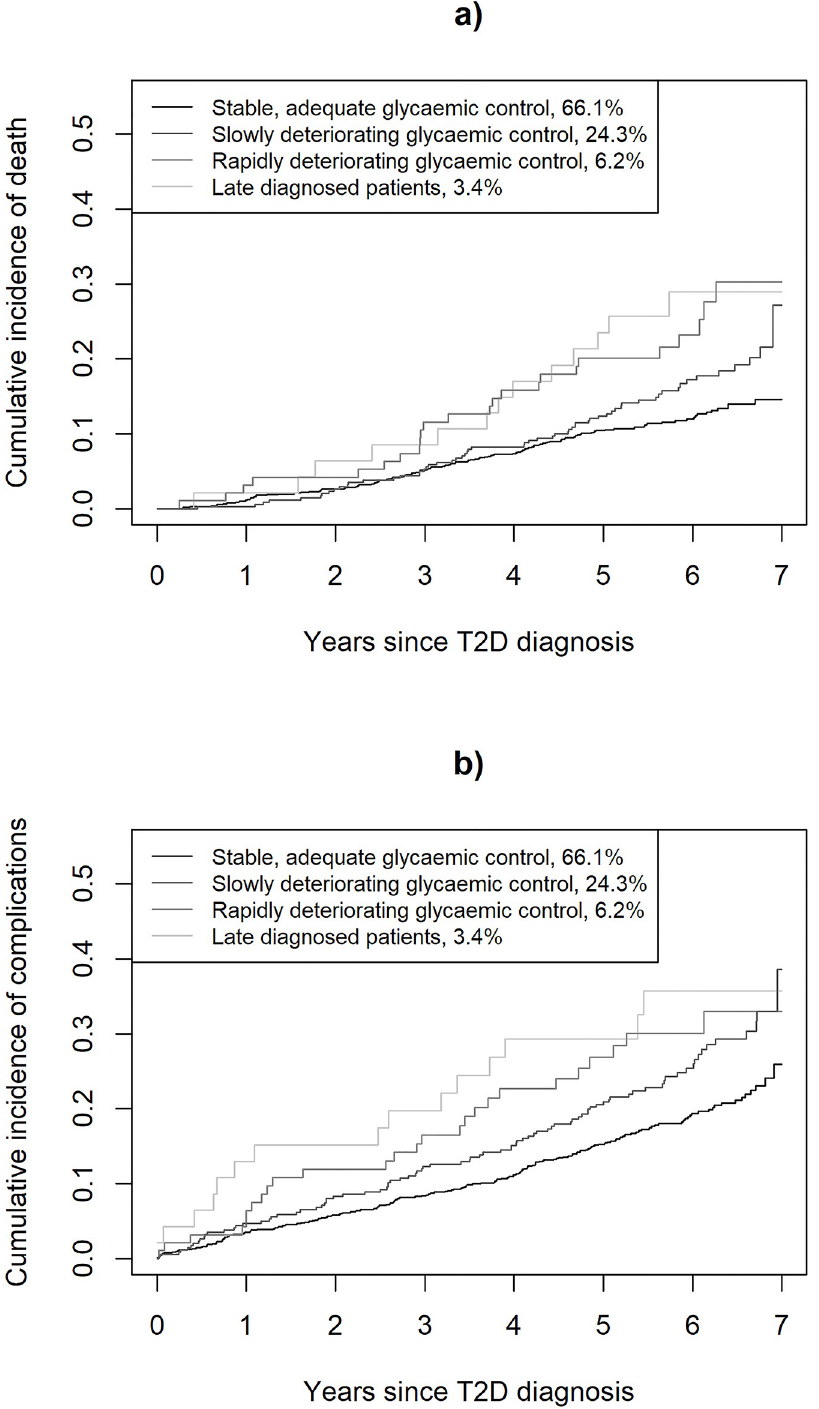
Fig 3. Cumulative incidences of health outcomes by the four HbA1c trajectories. (A) Cumulative incidence of death since T2D diagnosis. (B) Cumulative incidence of combined event of micro- and macrovascular complications since T2D